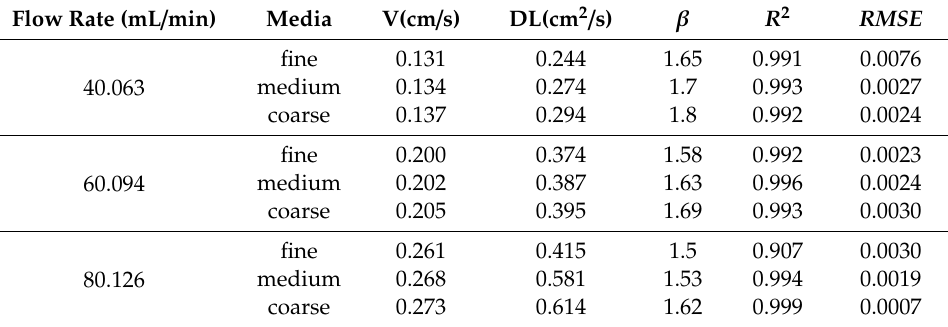
Table 2. Fitting parameters of CTRW-FEM for reactive migration in porous